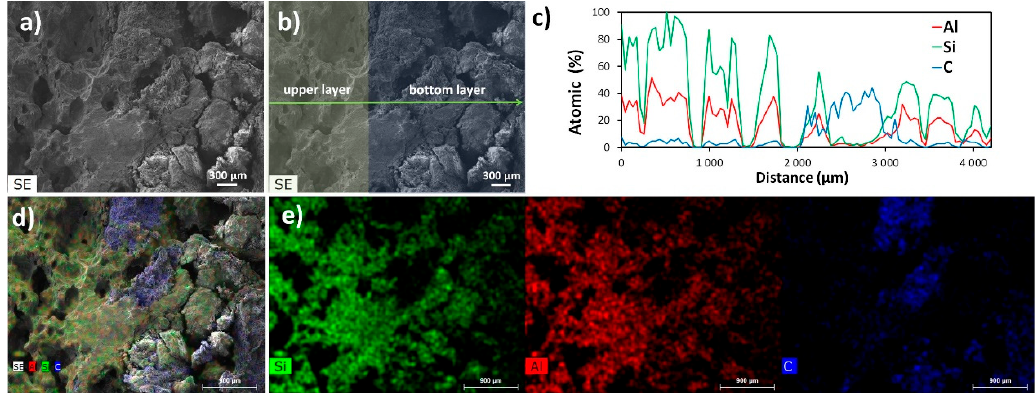
Figure 4. SEM micrographs ( a , b ), energy-dispersion spectroscopy (EDS) line profile ( c ) and elemental mapping ( d , e ) of the bi-layered composite prepared with 0.1 wt.% Al. In Figure 4b the two layers are identified using colors (porous upper layer — highlighted in light green; cork-containing (bottom) layer — highlighted in light blue) and the location and direction of EDS line profile identified by an arrow.